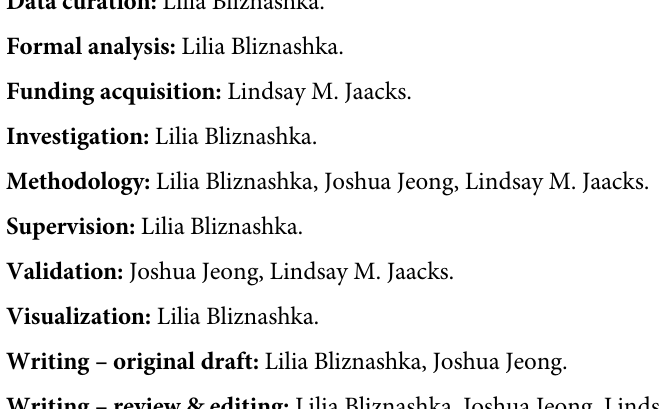
S5 Table. Associations between parental occupation and development domains among children aged 36–59 months. S6 Table. Associations between parental occupation and development among children aged 36–59 months. S7 Table. Associations between parental occupation and childcare practices among chil- dren aged 36–59 months. S8 Table. Associations between parental occupation and women’s empowerment among children aged 36–59 months. S9 Table. Heterogeneity of the associations between parental occupation, child develop- ment, childcare practices, and women’s empowerment by household location, household wealth, parental education, and country income level comparing both parents employed in agriculture vs. both parents employed in